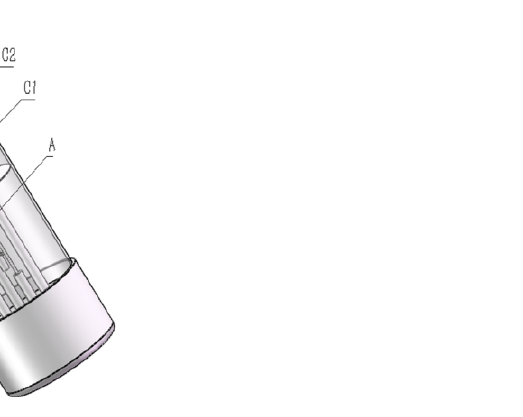
Figure 2. The optical path of atomic absorption spectrometry for Pb–Cd simultaneous determina- tion. HCL: high-performance composite hollow-cathode lamp; M1–M3 and M5: mirrors; M4: con- cave grating; G: graphite tube; S1–S2: slit components; P1–P2: photomultiplier tubes. To ensure that these high-performance composite hollow-cathode lamps could be used for the detection of Pb and Cd in cereals, lamp performance was investigated by testing the noise, drift, and sensitivity of three random composite hollow cathode lamps (Table 1). The results showed that the noise, drift, and consistency of the sensitivity met the requirements of the application. Table 1. Performance test of LCC-HCL (n = 3). Element